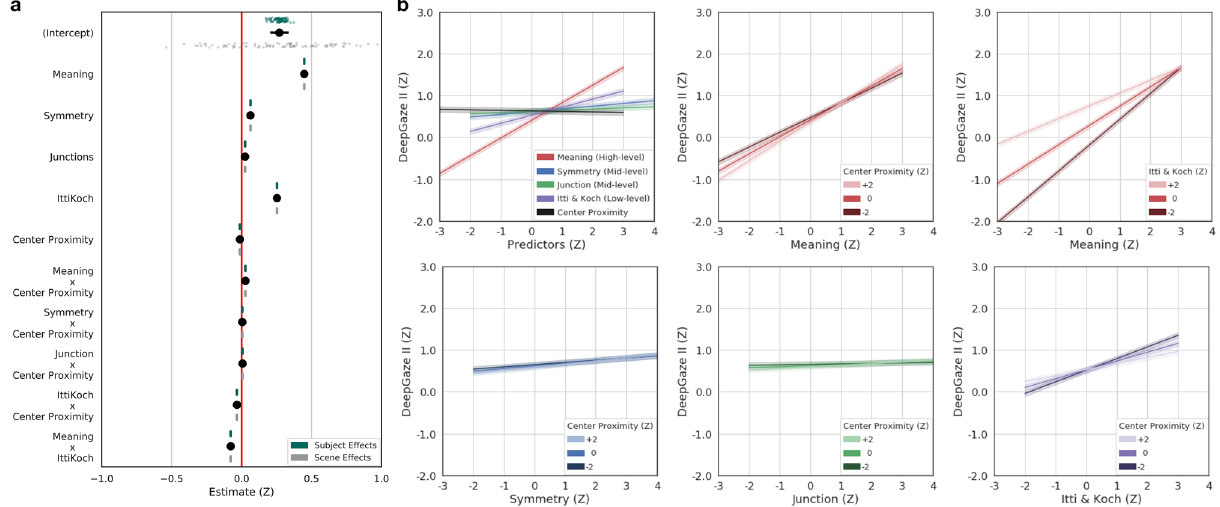
Figure 4. DeepGaze II LME model, marginal effects, and interactions. ( a ) Fixated DeepGaze II values as a function of low-, mid-, and high-level features and interactions. The black dots with lines show the fixed effect estimates and their 95% confidence intervals. Subject (green dots) and scene (grey dots) were both accounted for in the model as random intercepts. ( b ) Line plots of all model marginal effects and all model interactions. All error bands reflect 95% confidence intervals.